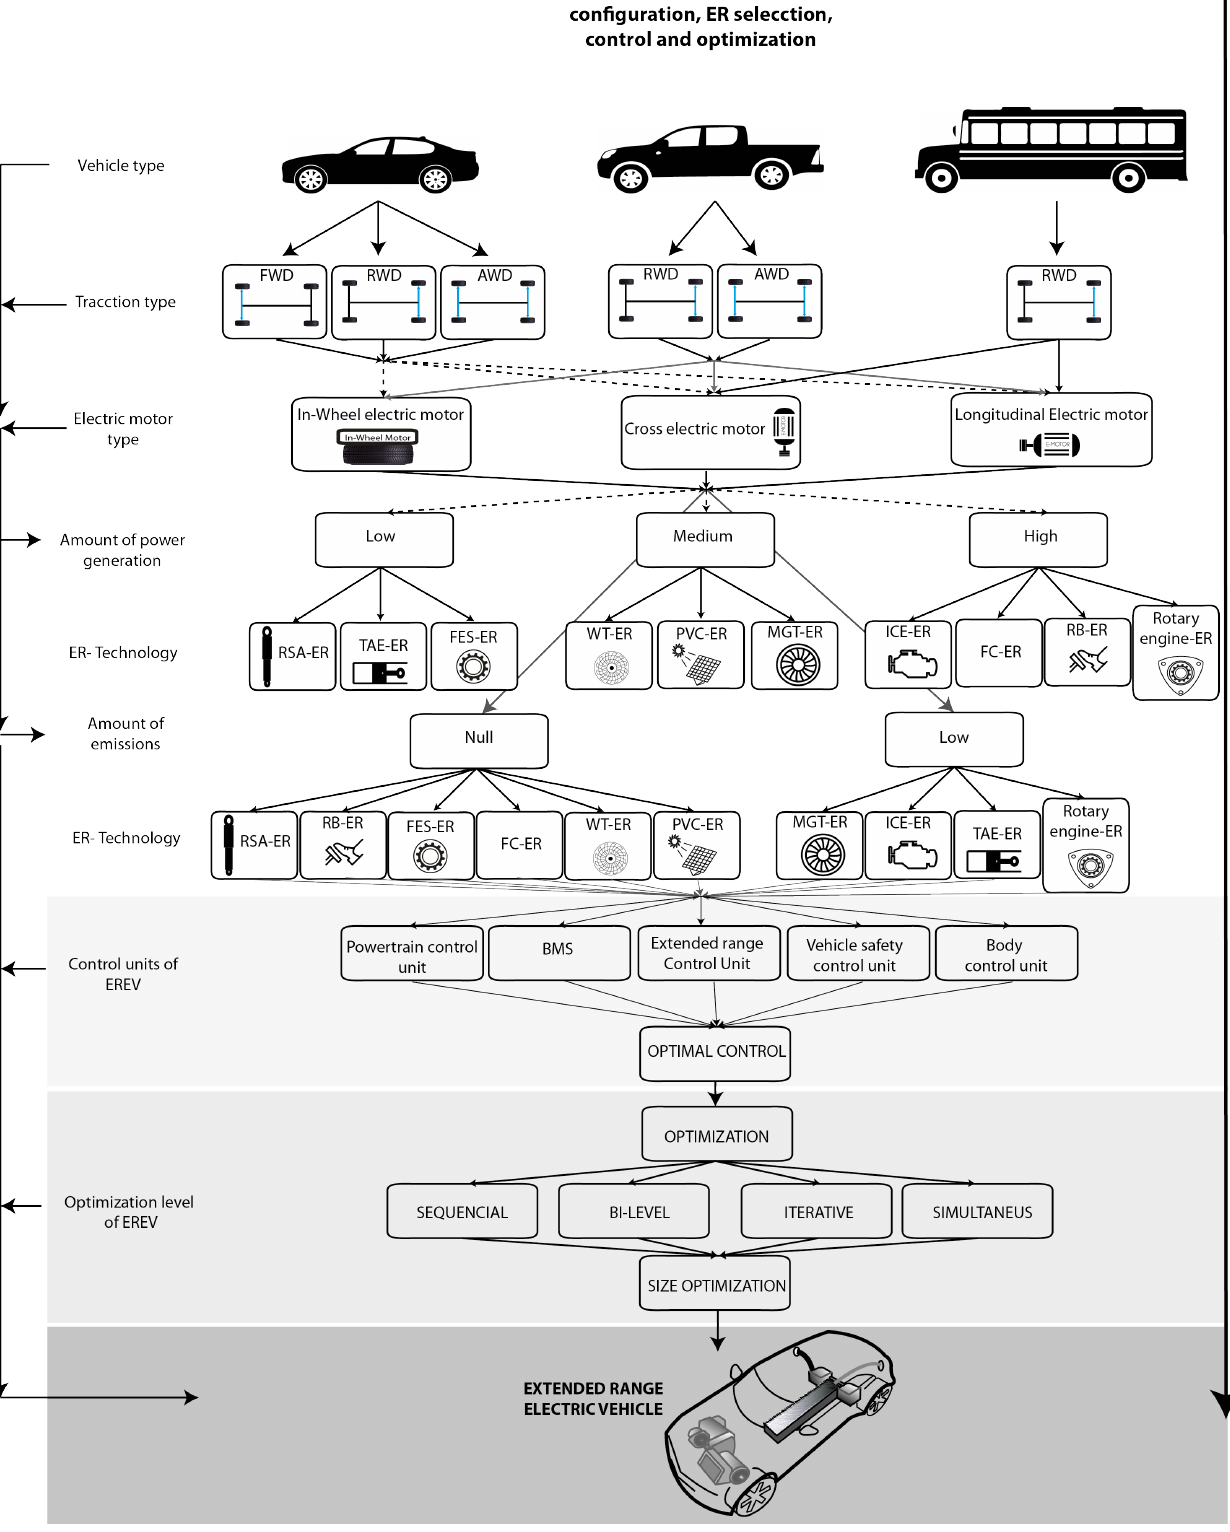
Figure 16. The process of designing an